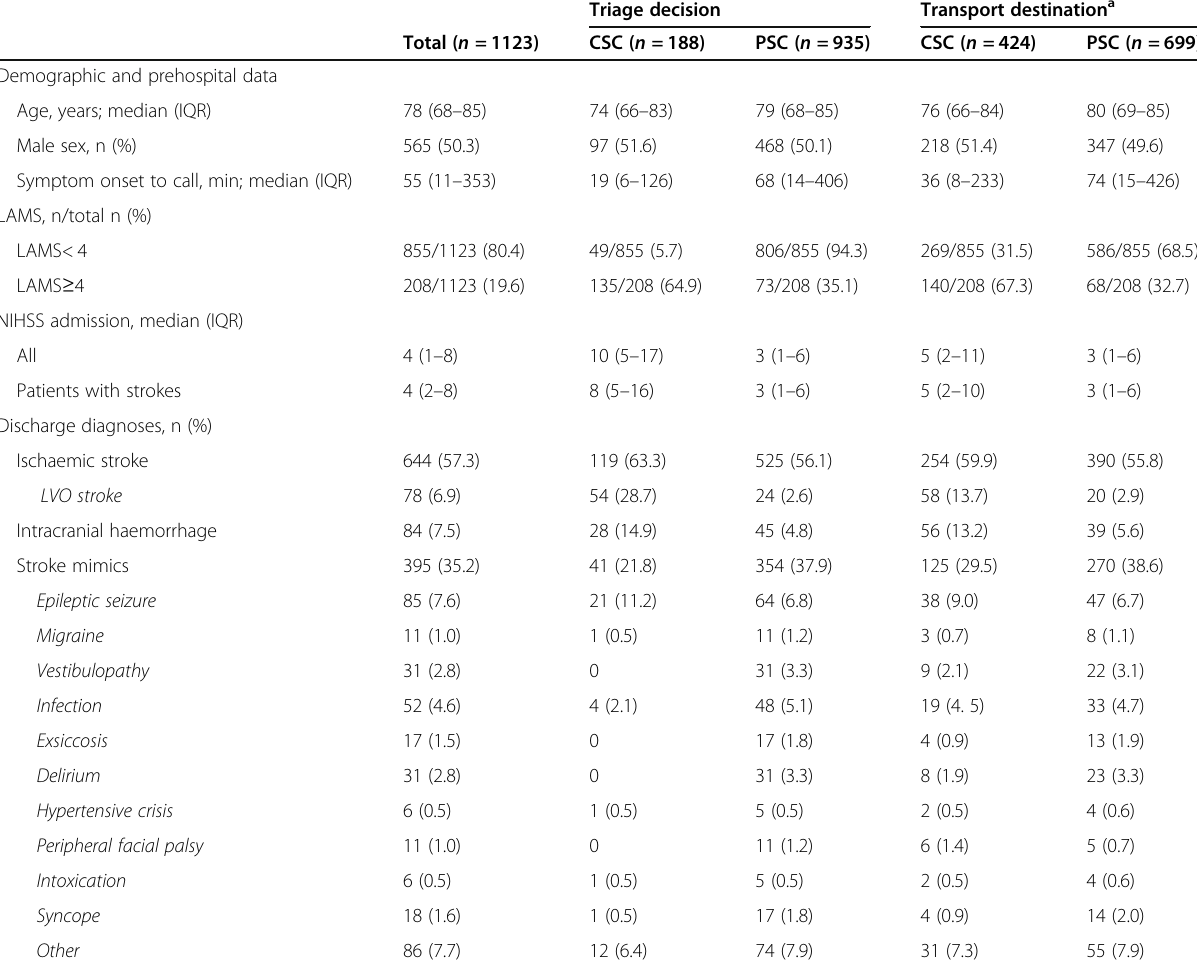
Table 1 Demographic and medical characteristics of the study population